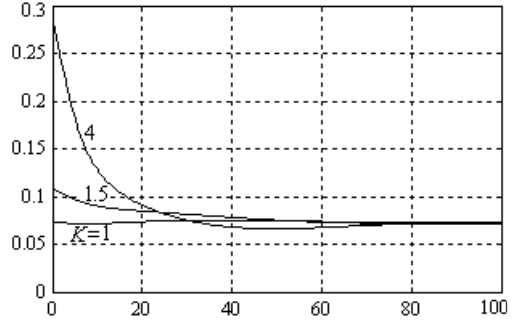
Figure 34. Control responses c ( t ) to a unit step setpoint for K = 1; 1.5;